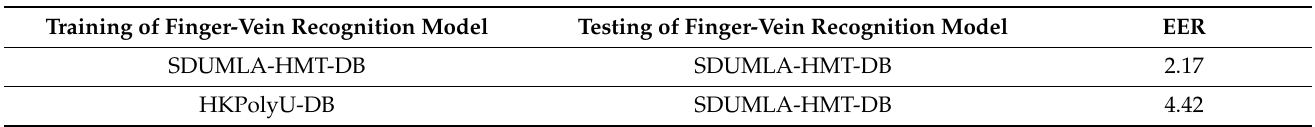
Table 9. Comparisons of EER with same domain and cross-domain environment without our domain adaptation method (unit: %).